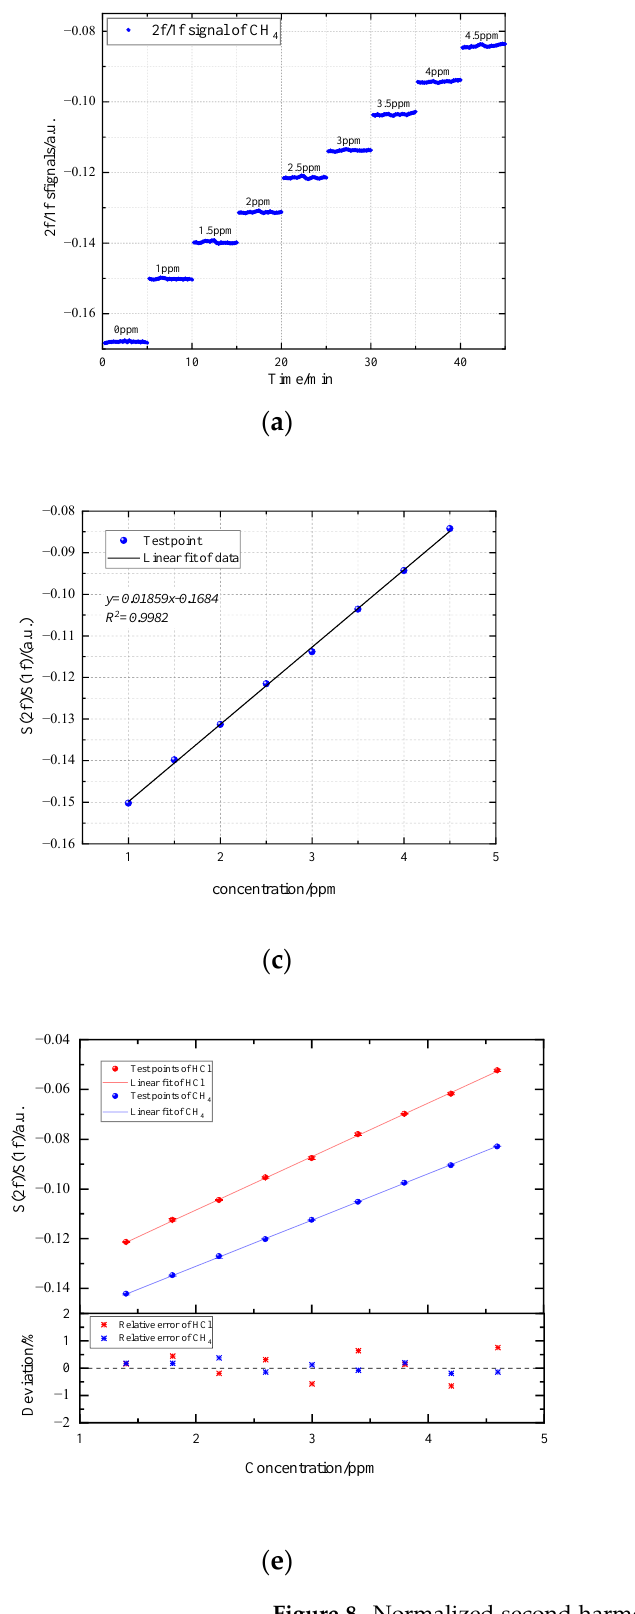
Figure 8. Normalized second harmonic (2f/1f) signal: ( a ) normalized second harmonic signal of CH 4 .; ( b ) normalized second harmonic signal of HCl.; ( c ) fitting curve of CH 4 .; ( d ) fitting curve of HCl.; ( e ) Deviation analysis of random test points and fitting curves.